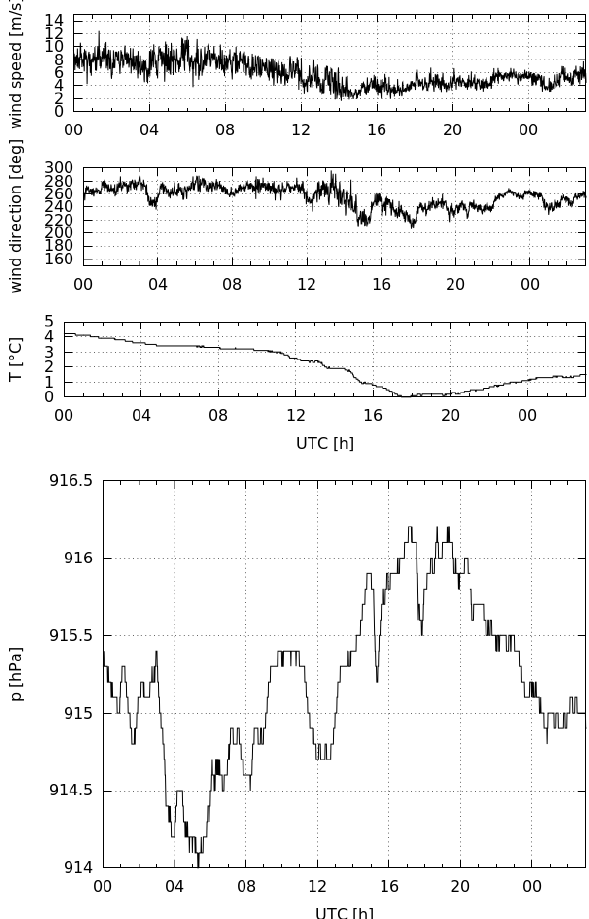
Figure 9. Time series of wind speed, wind direction (measured by a ultrasonic anemometer) and temperature (upper panel). Measure- ments are taken at the Hohenpeißenberg observatory. The corre- sponding surface pressure (hPa) is shown in the lower panel. Data start at 00:00UTC, 5 January 2013, and end at 03:00UTC, 6 Jan- uary